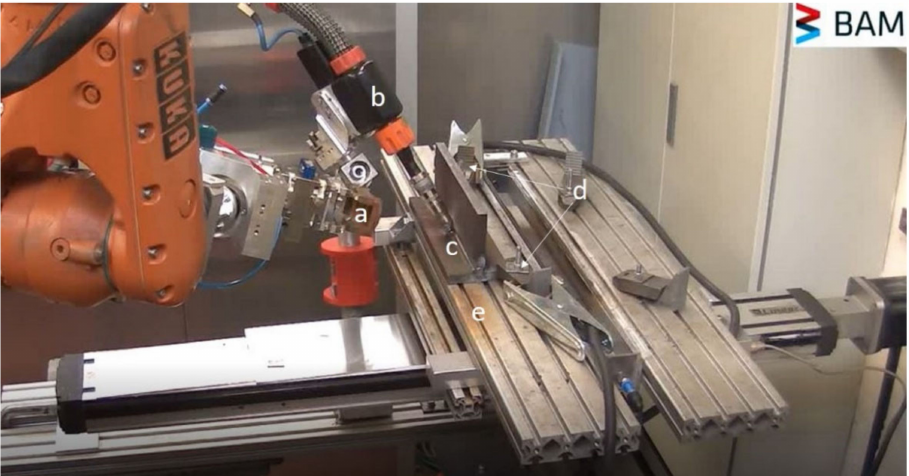
Figure 2. General disposition of hybrid welding process: ( a ) laser head, ( b ) GMA torch, ( c ) workpieces, ( d ) clamps, and ( e ) working table.